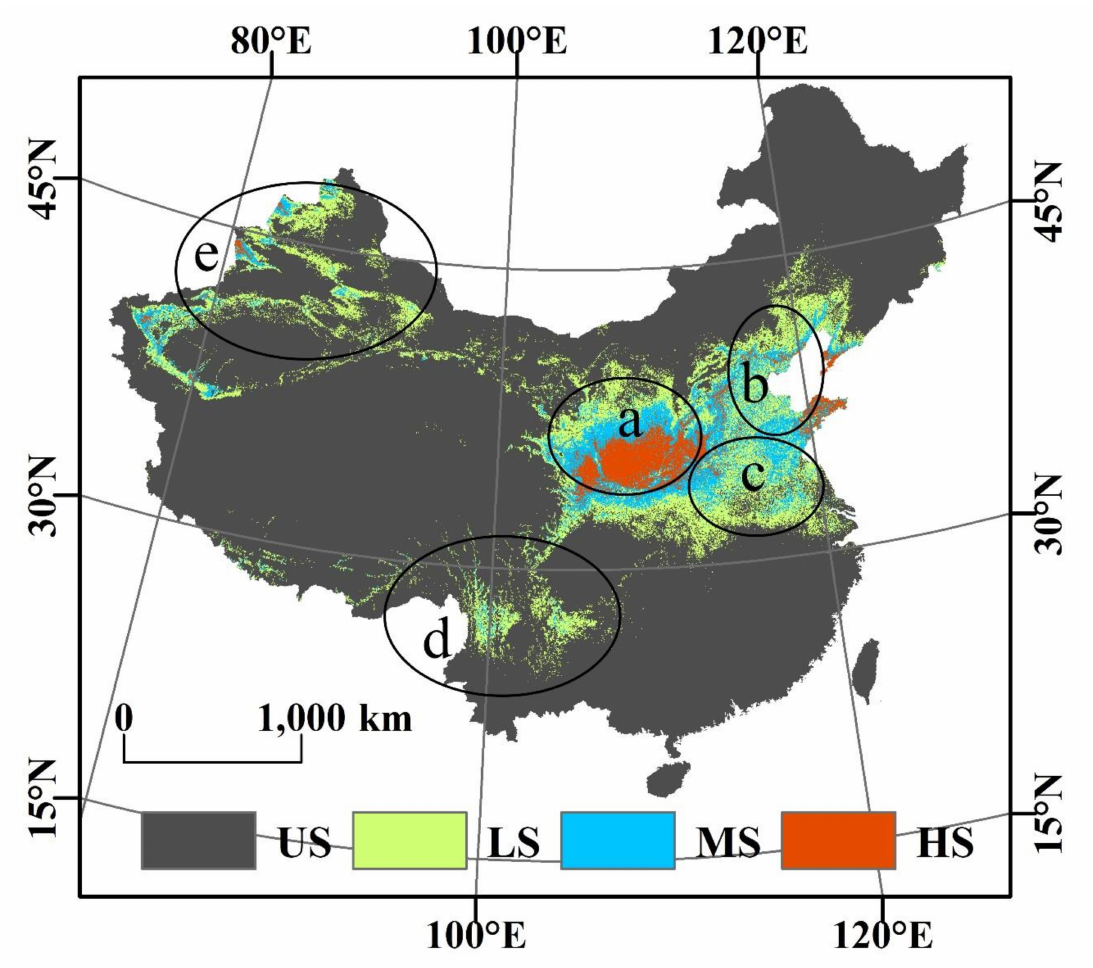
Figure 2. Potential distribution map of Valsa mali in the current climate environment. The US, LS, MS, and HS represent the suitability of unsuitable, low suitable, moderately suitable, and highly suitable, respectively. Five ellipses represent the major apple–producing area of China: ( a ) the Loess Plateau area, ( b ) the Bohai Bay area, ( c ) the Old Yellow River Basin area, ( d ) the Cold Highland area of Southwest China, and ( e ) the Xinjiang